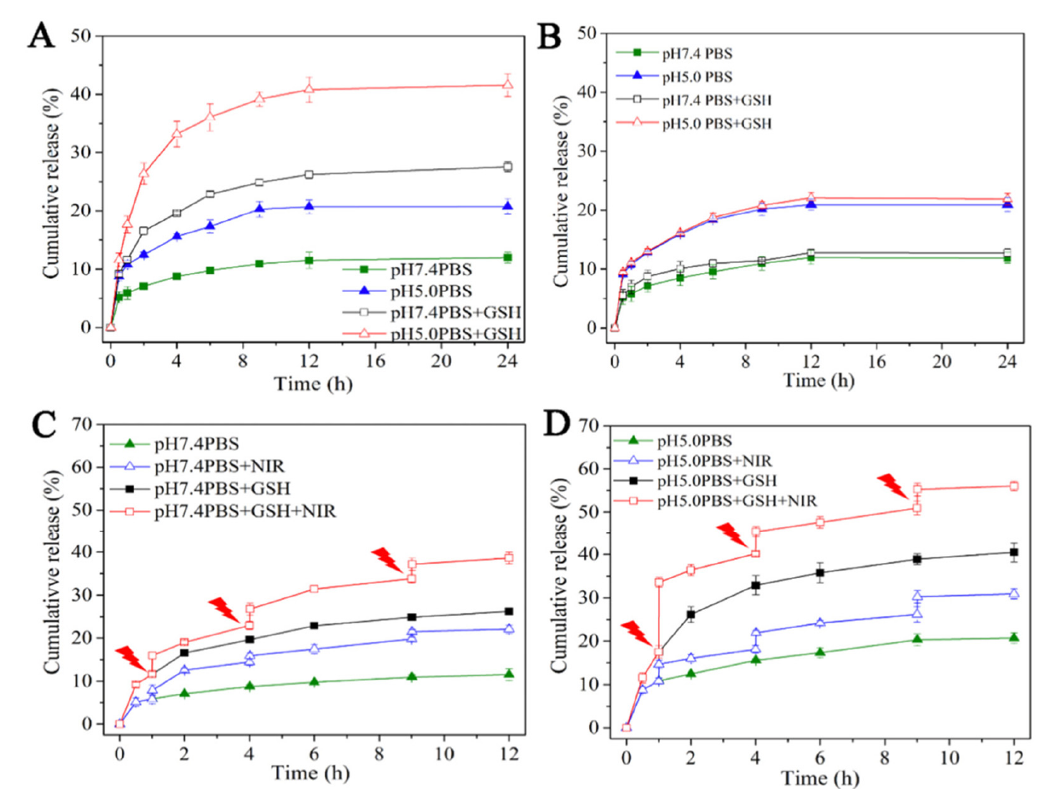
Figure 15. The cumulative release ( A ) MSN-PDA, ( B ) MSN-S-S-PDA, ( C ) MSN-S-S-PDA NIR pH 7.4, and ( D ) MSN-S-S-PDA NIR pH 5 [108]. Reprinted from Materials Science and Engineering C,